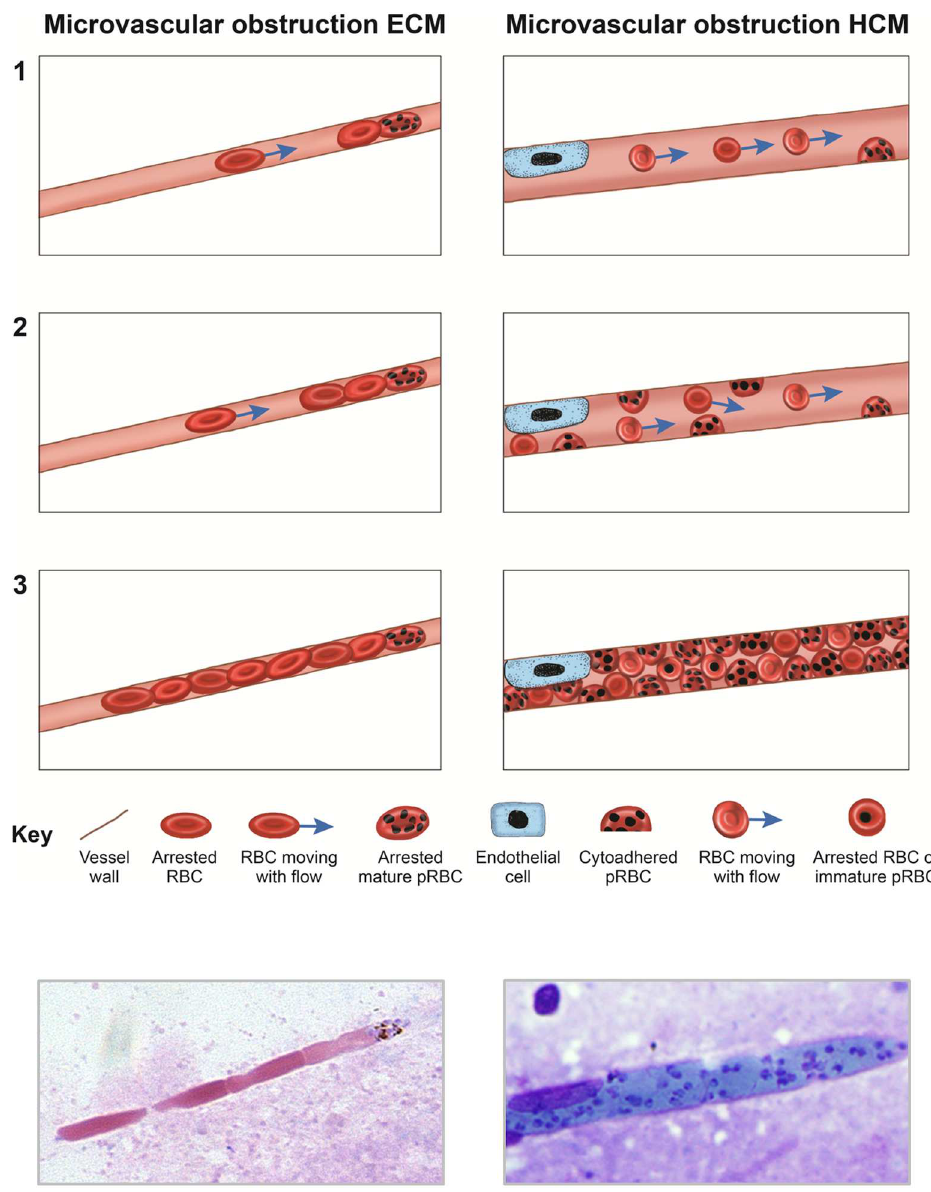
Fig 11. Models for pRBC-dependent microvascular obstruction in ECM and HCM. In a step-wise fashion (1–3) , models show how pRBC-dependent microvascular obstructionoccurs duringmalaria-induced encephalopathy in mice (left panels) and humans (right panels), respectively.Bottom left panel is a quik-diff stainedbrain smear taken from a transcardially-perfused mouse duringthe late-stagesof ECM; uninfected erythrocytescan be seen to accumulatebehindan arrested late-stage schizont within a narrowmurine capillary(reproduced from Fig 3H). Bottom right panel is a reverse Fields stainedbrain smear taken from a patient who died from CerebralMalaria; the length of the distendedcapillaryis densely packed with mature trophozoites (courtesy of Prof. D Milner).